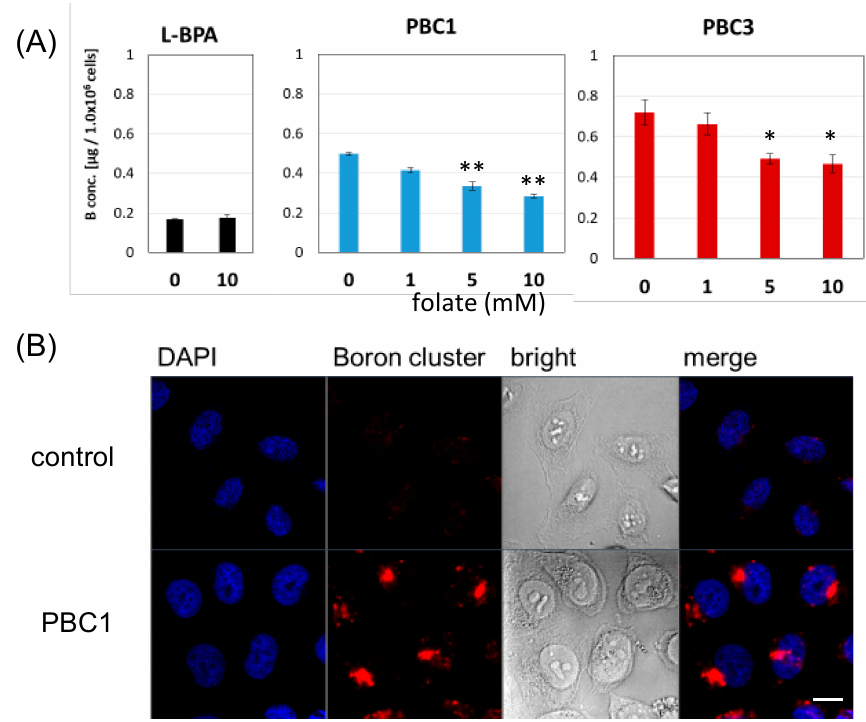
Figure 3. ( A ) Folate concentration-dependent boron accumulation of PBC 1, PBC 3, and L-BPA into HeLa cells. HeLa cells were incubated with PBC 1, PBC 3 (100 ppm B), or L-BPA (25 ppm B) in the various concentrations of folate. Statistical significance: * p < 0.005 and ** p < 0.001 compared with controls (no folate). ( B ) Cellular distribution of PBC 1 in HeLa cells. Immunostaining was carried out using anti- closo -dodecaborate antibody. Red color: the localization of PBC 1; blue color: DAPI-stained nucleus. Scale bar: 20 μ m.